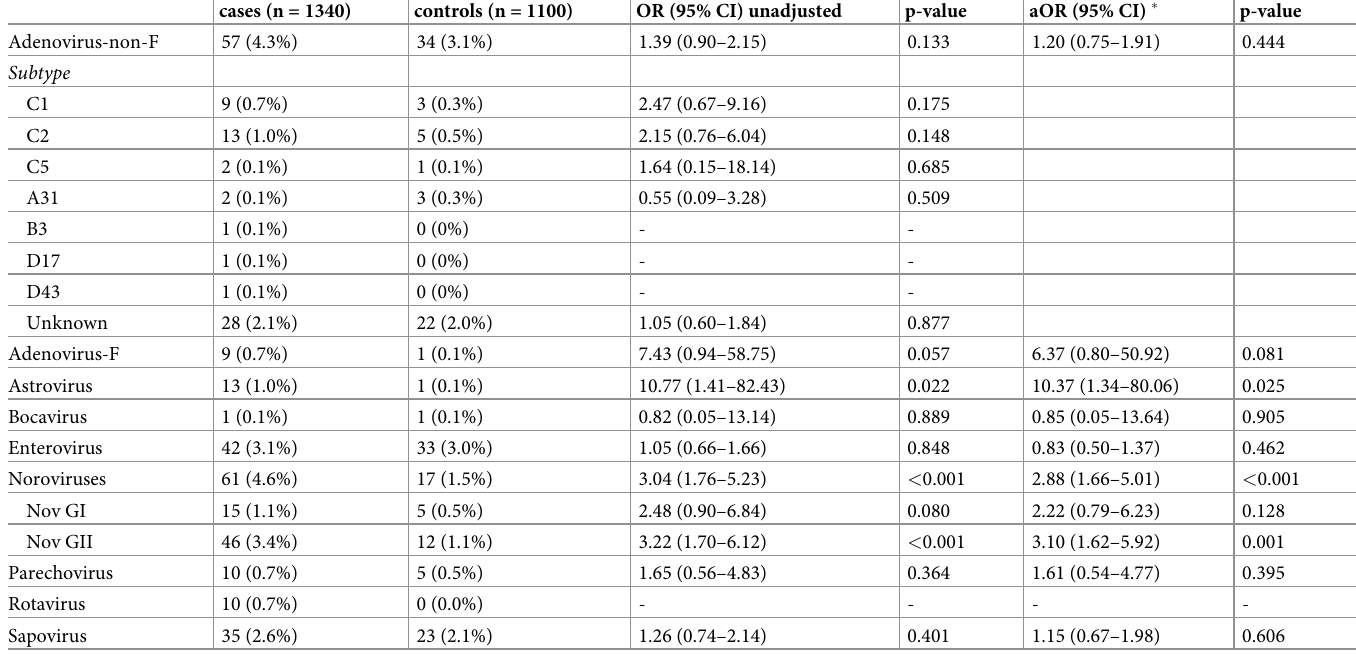
Table 1. Prevalence of the investigated viruses in the general population with symptoms of gastroenteritis (cases, N = 1340) and those without symptoms (controls, N =